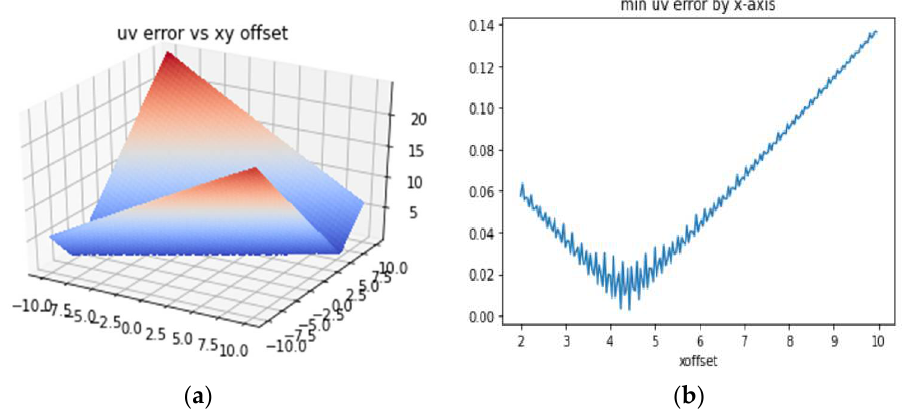
Figure 8. Error function of the model parameter and visualization in the x and y dimensions: ( a ) error function at a 10 × 10 region near the optimum point, ( b ) error function contains a gradient valley where many local minima exist.